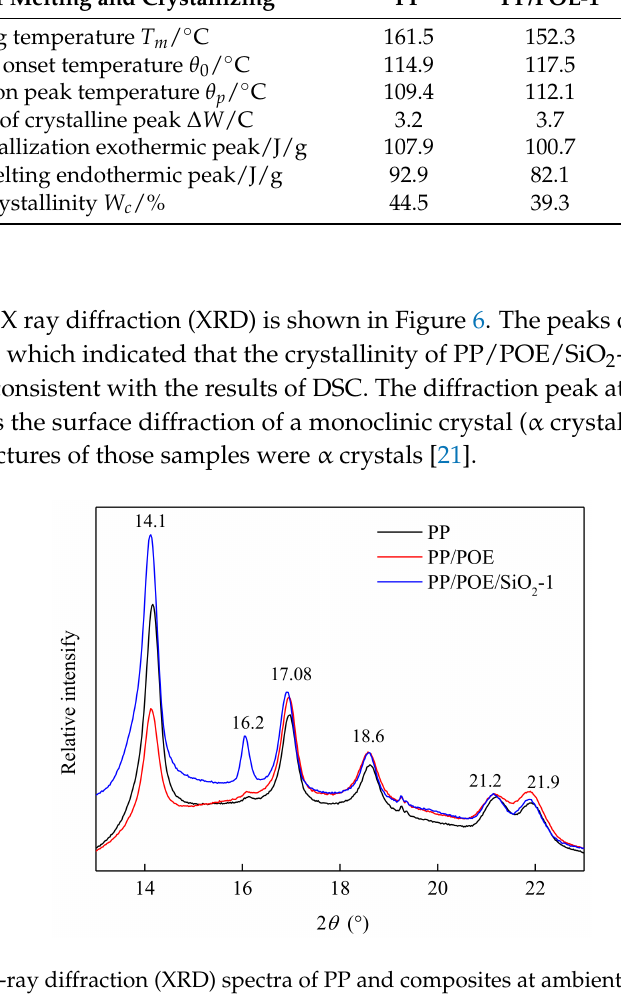
Figure 6. X-ray diffraction (XRD) spectra of PP and composites at ambient